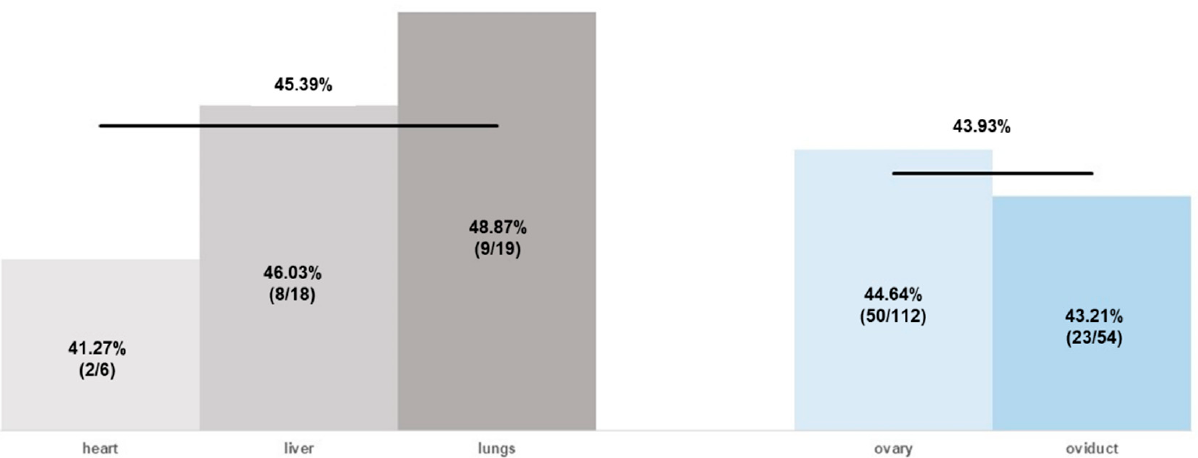
Figure 2. Percentage proportion of E. coli resistance presented as mean value by comparing the isolates based on their isolation site (total numbers are given in brackets). Isolates from the heart, liver, and lungs were allocated to group 1, and isolates from ovaries and oviducts to group 2.